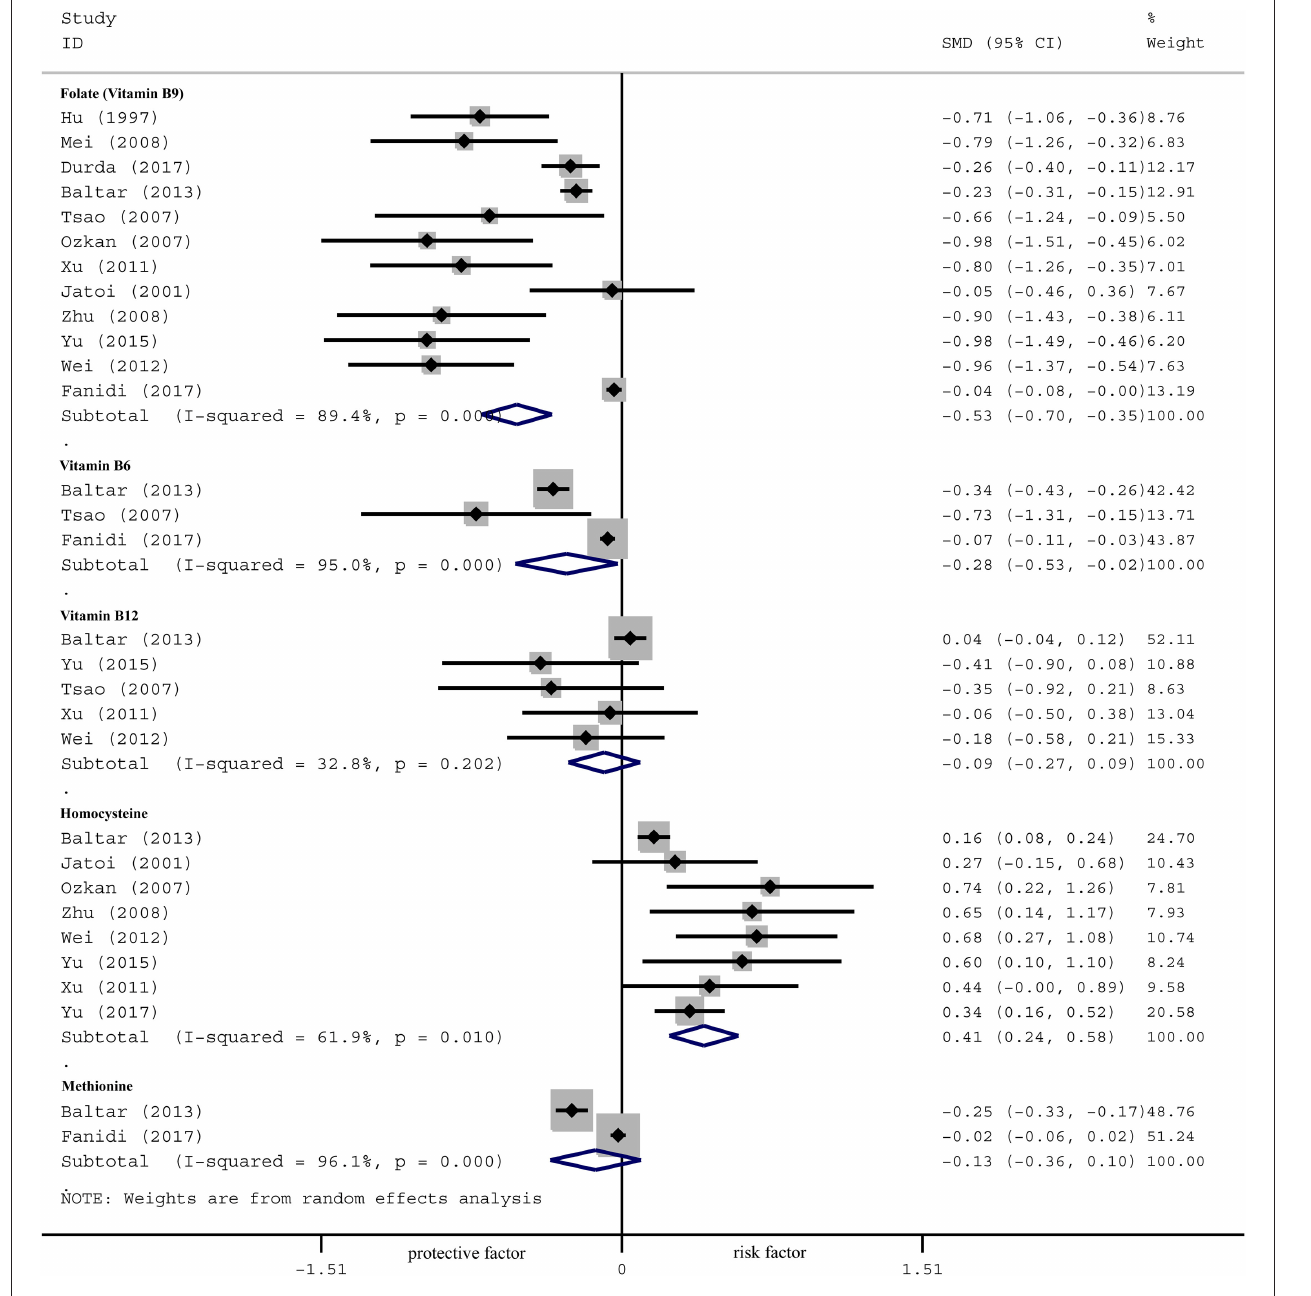
FIGURE 2 | Forest plot for OCM-related factors (folate, vitamin B6, vitamin B12, homocysteine, and methionine) and the risk of lung cancer.